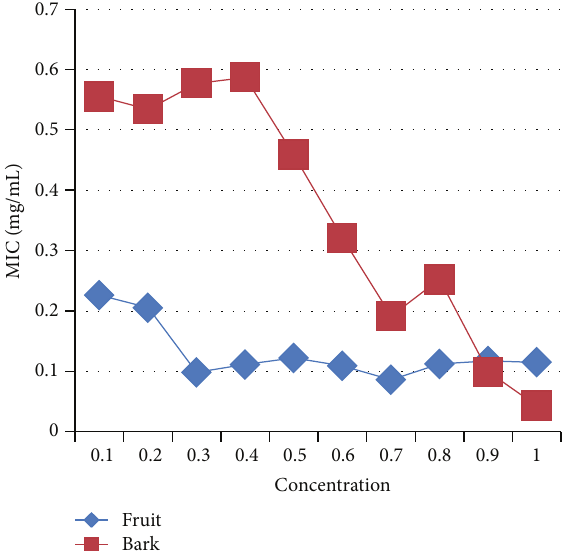
Figure 13: MIC values (mg/mL) exhibiting potential of bark and fruit of C. ambrosioides against A. oryzae .